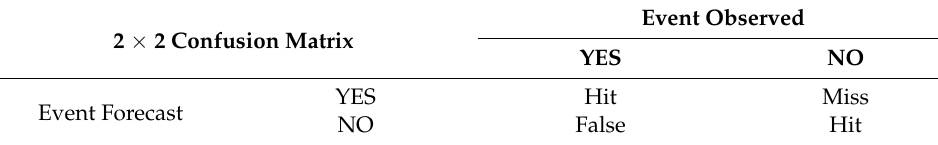
Table 3. The 2 × 2 confusion matrix [39].